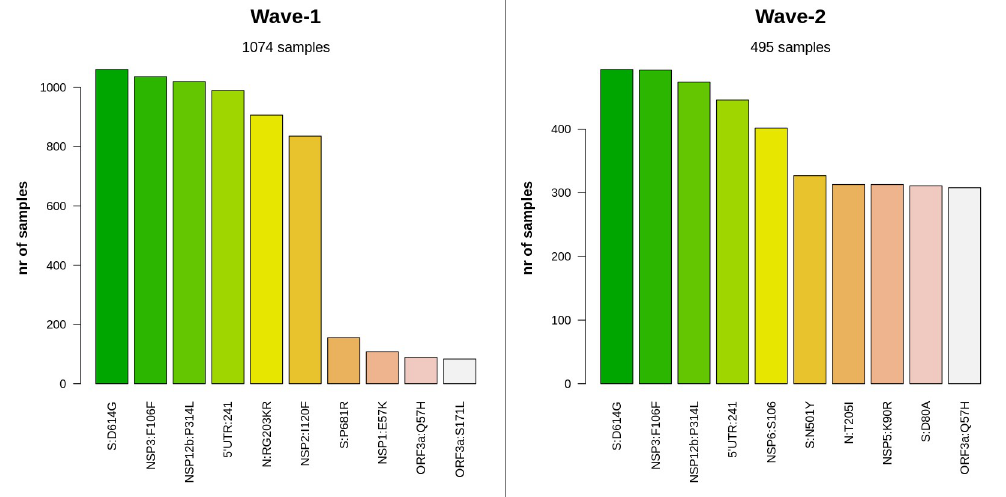
Fig 6. Number of most frequent protein level alterations among two waves in Bangladesh. The four most frequent amino acid substituting events had the same type of distribution for both waves. Besides, some mutations in spike and nucleocapsid protein (e.g., S:N501Y, N:T205I, S:D80A) were found in a significant amount in wave-2. Furthermore, the ORF3a:Q57H variant, which is a marker variant for GH clade, was also very common in this